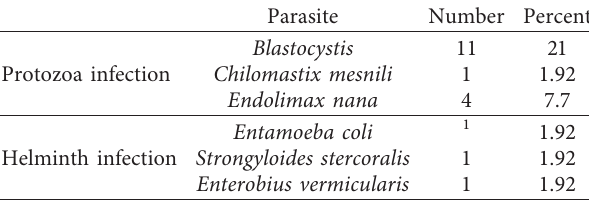
Table 2: The frequency of intestinal parasites (helminth and protozoa) in children with different malignancies.